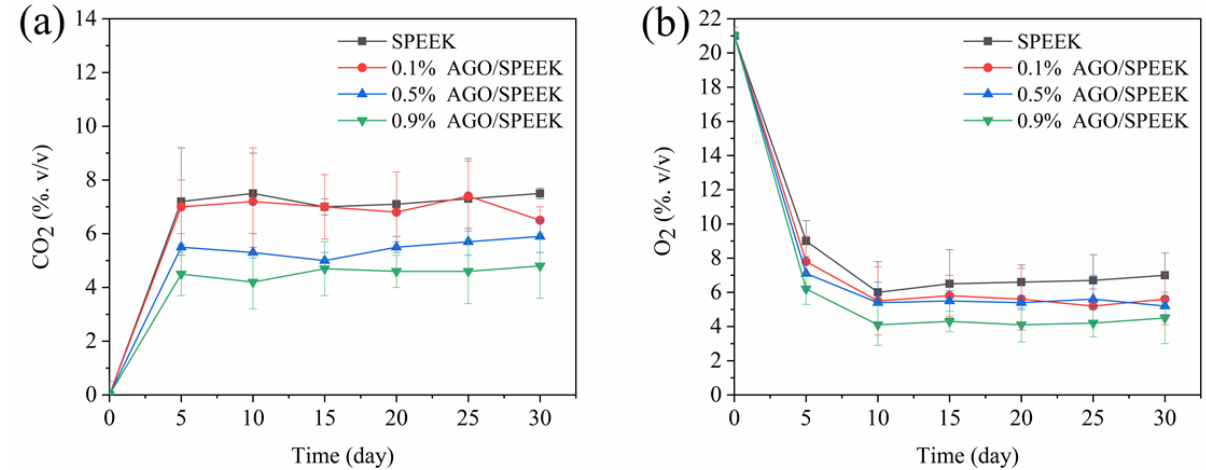
Figure 5. Internal atmosphere composition under AGO/SPEEK films packaging in the storage of cherry tomatoes. ( a ) CO 2 , ( b ) O 2 .